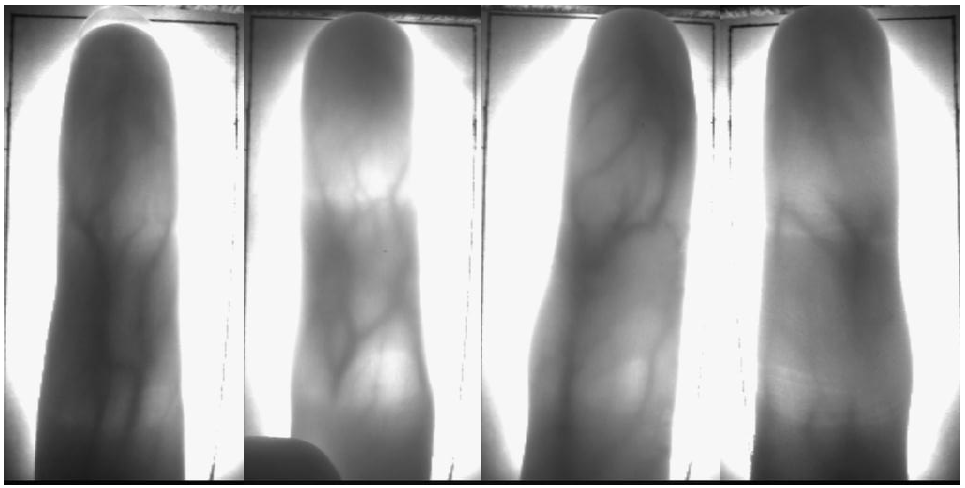
Figure 6. Finger images from the HKPU-FV